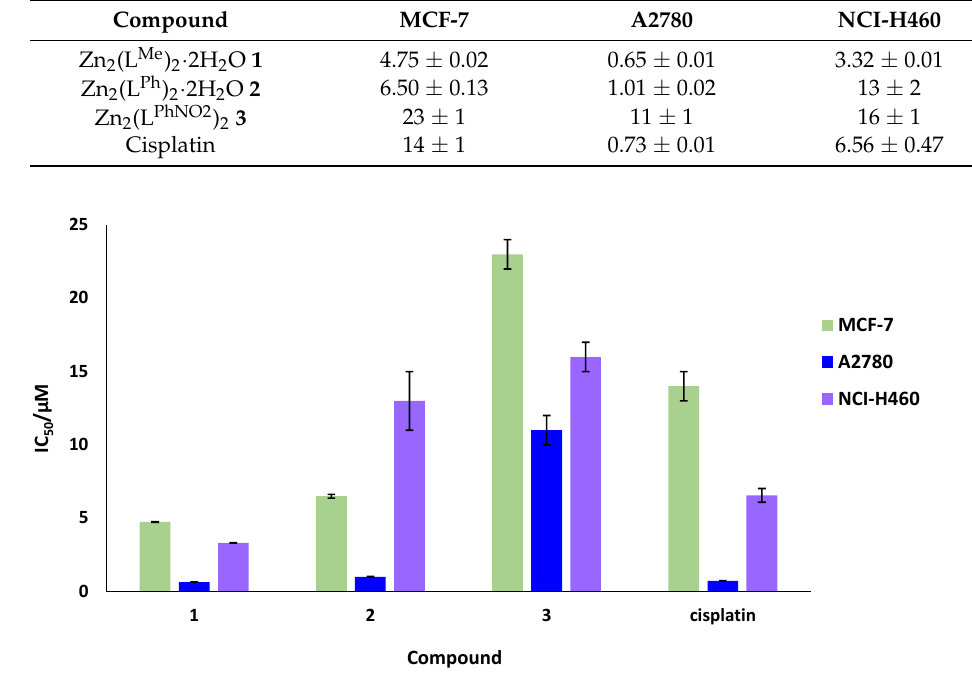
Figure 8. Representation of the IC 50 values for zinc helicates and cisplatin against MCF-7, A2780 and NCI-H460 tumor cell lines.